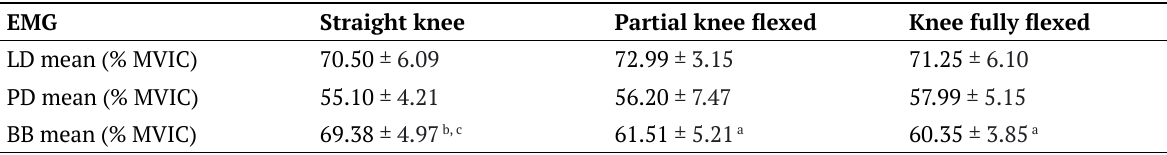
Table 3. EMG reading of eccentric phase during chin up between positions EMG Straight knee Partial knee flexed Knee fully flexed LD mean (% MVIC) 50.71 ± 3.72 51.87 ± 2.39 50.83 ± 2.06 PD mean (% MVIC) 41.76 ± 2.12 40.85 ± 3.83 40.42 ± 4.74 BB mean (% MVIC) 48.01 ± 4.48 48.00 ± 5.37 50.54 ± 6.40 a Significantly difference from straight knee position; b Significantly difference from partial knee flexed